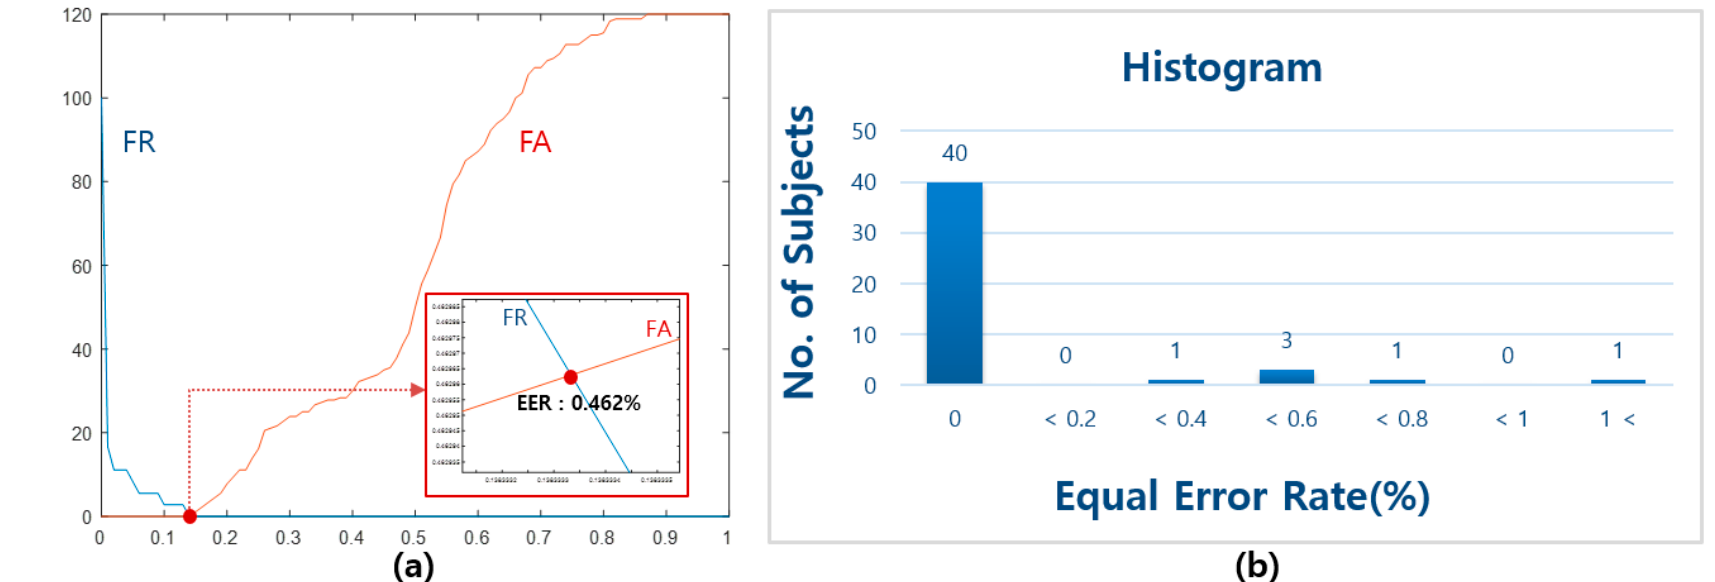
Figure 9. ( a ) Example of the EER depending on individuals (subject no. 41); ( b ) a histogram of the EER (Equal Error Rates) (average EER is 0.143%).